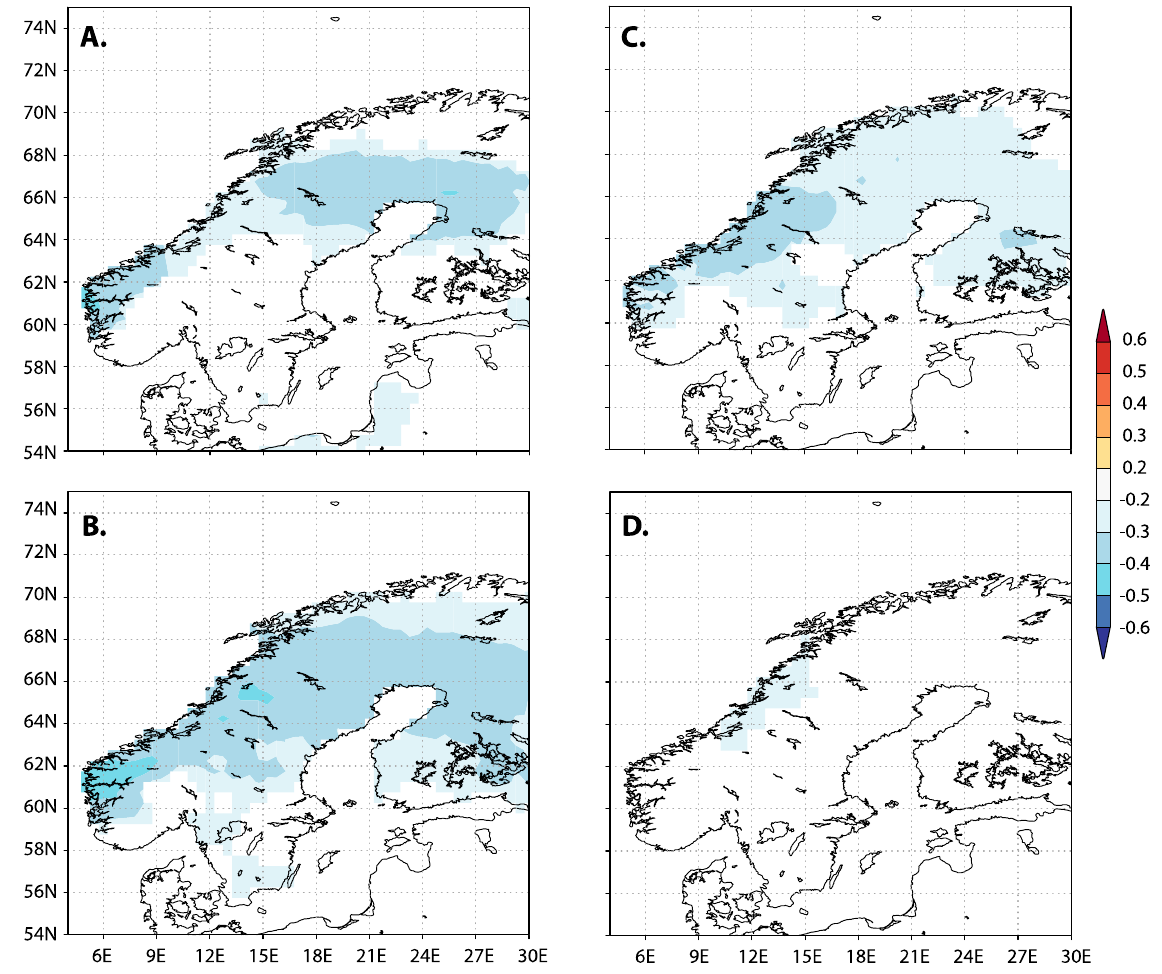
Figure 3. Field correlations between the sea ice content over 70–75 N and 80–60 W and 3-month SPEI index for April − May ( A ), May–June ( B ), June–July ( C ), and July–August ( D ). Areas with significant correlation ( p < 0.10) are colored. The value and direction of correlation are shown by the color